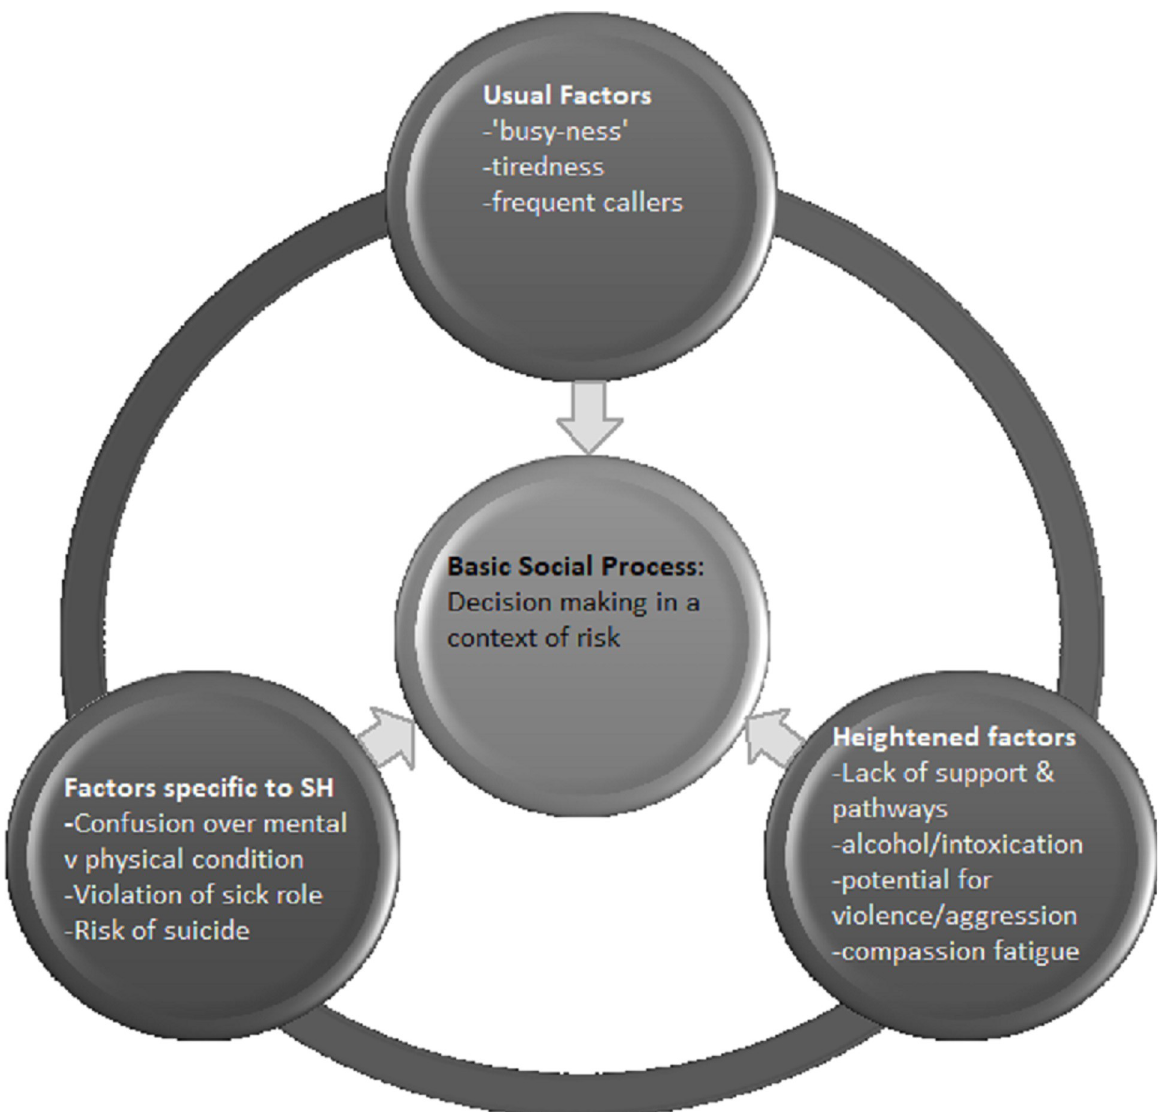
Fig 1. Overview of Grounded Theory (GT): Wicked complexity in paramedics’ care for people who self-harm.